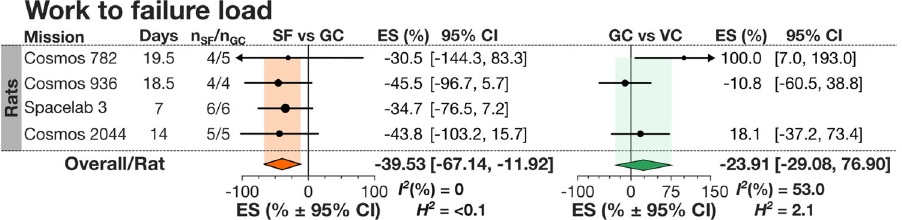
Fig. 4 Space fl ight-induced changes in work to failure load in rats. Forest plot of changes in work to failure load in space fl ight animals (SF) compared to ground control (GC) ( Left ); and GC compared to vivarium control animals (VC) ( Right ). Missions are ordered by mission year; mission name, duration (Days), SF and GC sample sizes (n SF /n GC ) are shown. Circle/line: effect size (%) and 95% CI, the size of the circle is proportional to the mission ’ s weight. Orange diamonds : overall effect size and 95% CI for animal strain was only applied to rats, in which the decreases to max load and stiffness were only signi fi cant in Sprague-Dawley rats, and not in Wistar rats, while density and calcium content changes were similar for both strains (Supplementary Fig. 2b). All (Supplementary Fig. 2c). Weight at time of sacri fi ce, or Δ weight SF space fl ight rats were male, therefore subgroup analysis for animal and GC did not signi fi cantly affected space fl ight outcomes sex was only applied to mice. Comparing outcomes of BMD by sex (Supplementary Fig. 2d, e). in mice demonstrated a signi fi cant decrease in female but not in Mission-related covariates included mission duration, SF hous- male mice, although the number of datasets for male mice was ing - either single or grouped, and year of mission launch. limited to 2 (Fig. 7b). Animals were obtained primarily from